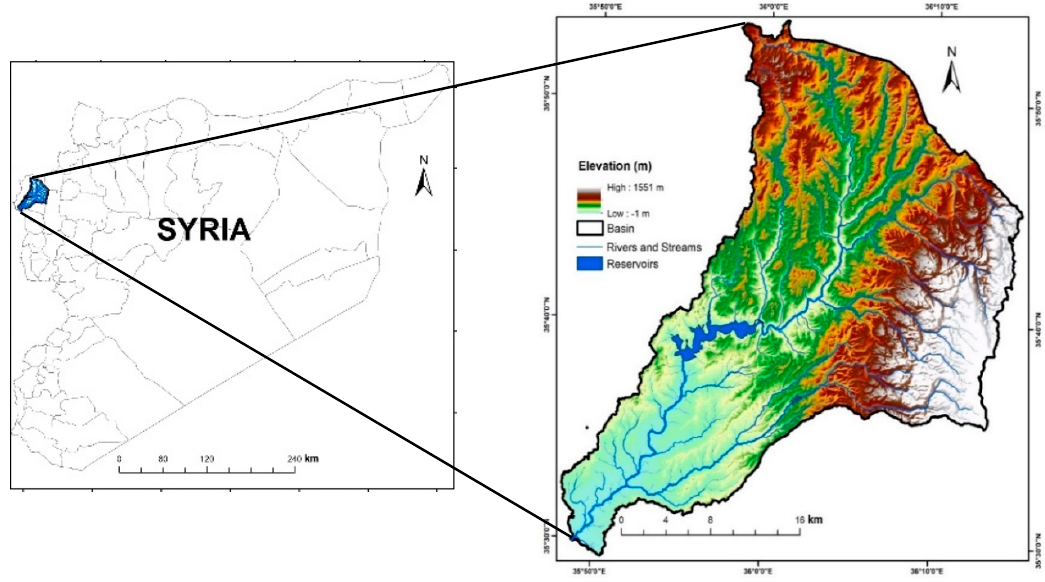
Figure 1. Location and topography of the study area in Syria.